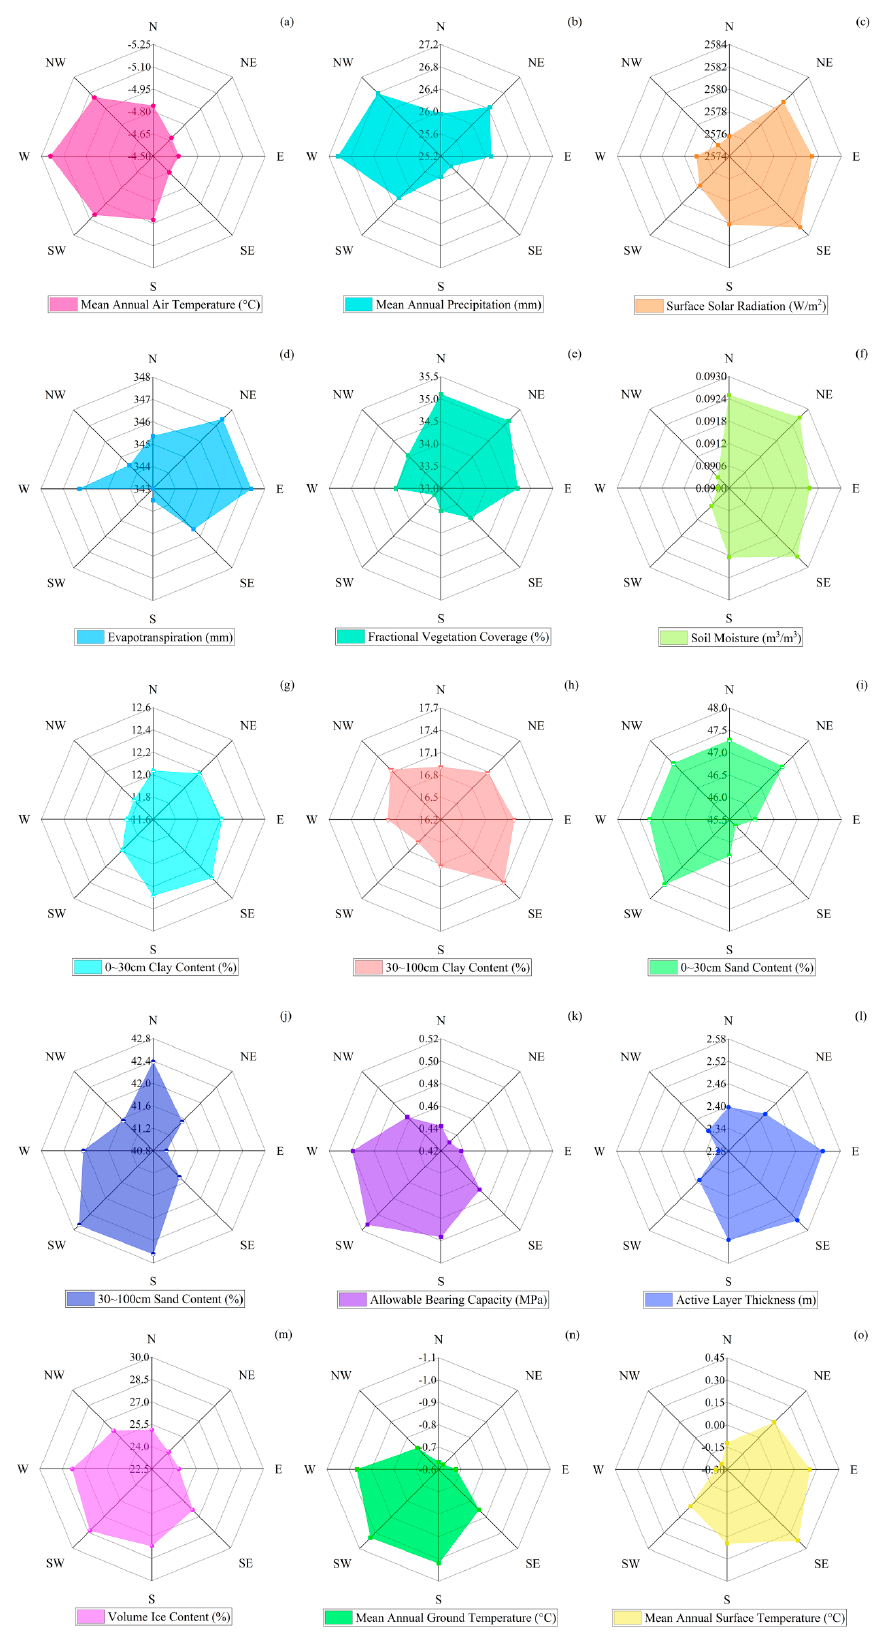
Figure 7. Changes in risk factors considering aspect: ( a ) MAAT; ( b ) MAP; ( c ) SR; ( d ) ET; ( e ) FVC; ( f ) SM; ( g ) CC1; ( h ) CC2; ( i ) SC1; ( j ) SC2; ( k ) ABC; ( l ) ALT; ( m ) VIC; ( n ) MAGT; ( o )